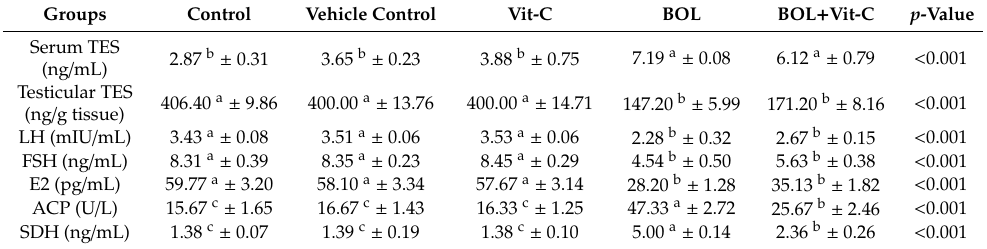
E ff ect of boldenone (5 mg / kg bwt / once a week, eight weeks) and / or vitamin C (120 mg / kg b.wt / daily, eight weeks) treatment on hormonal variables and testicular enzymes of adult male Wister